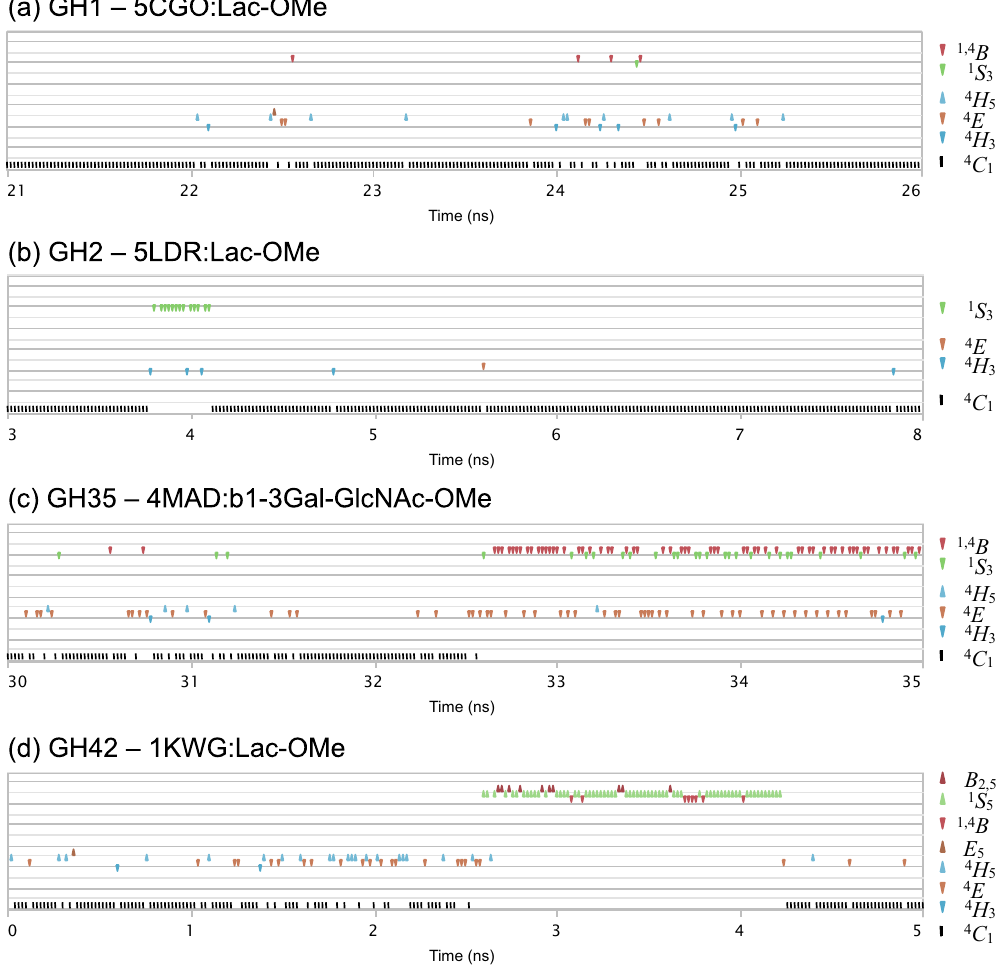
Figure 5. Puckering variation with time observed at subsite − 1 during MD simulations in families GH1, GH2, GH35 and GH42. Selected 5 ns time segments that display conformational itineraries going from basal 4 C 1 up to equatorial boat ( B ) and skew-boat ( S ) states are observed: ( a ) 1-methyl- β -lactoside = Lac-OMe (GH1, PDB ID: 5CGO); ( b ) 1-methyl- β -lactoside = Lac-OMe (GH2, PDB ID: 5LDR); ( c ) β -1,3-LacNAc-OMe (GH35,